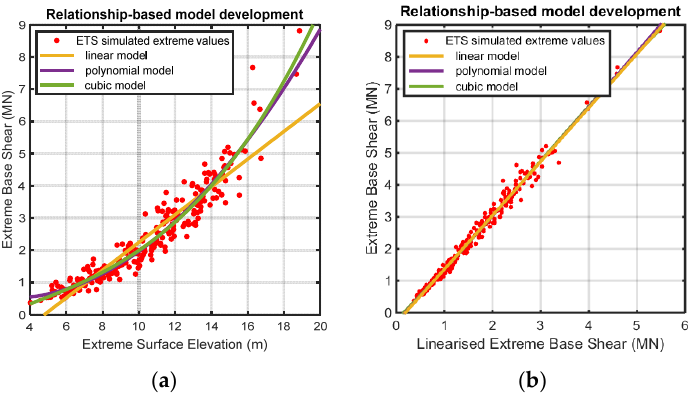
Figure 4. ( a ) ETS-Reg SE model based on the ETS-R SE relationship. ( b ) ETS-Reg LR model based on the